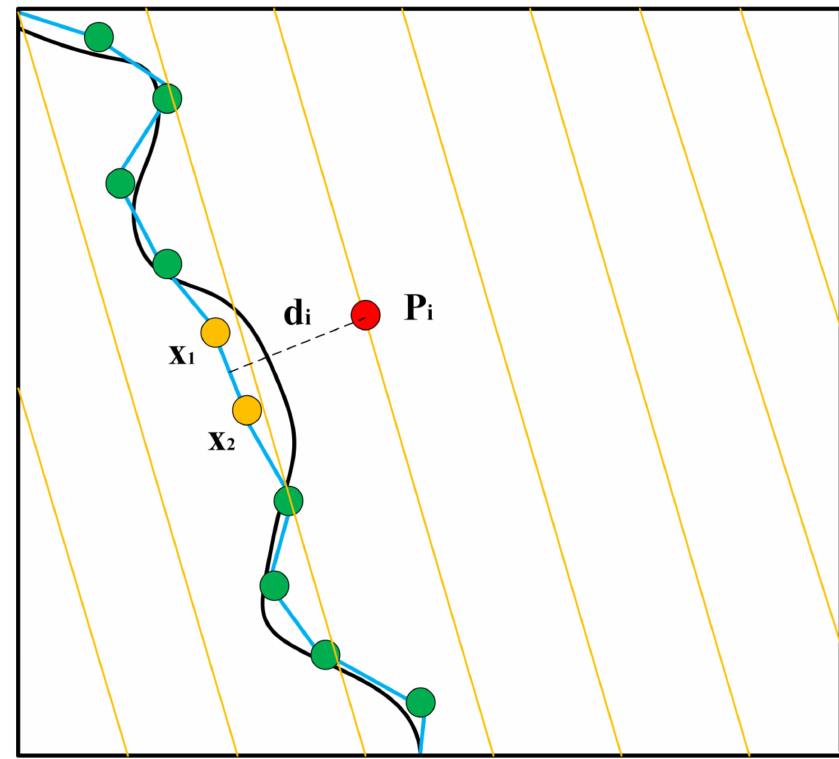
Figure 3. Principle of PL-ICP